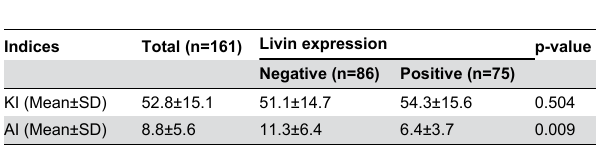
Table 1. Correlations between Livin expression and tumor cell proliferation and apoptosis in colorectal cancers.